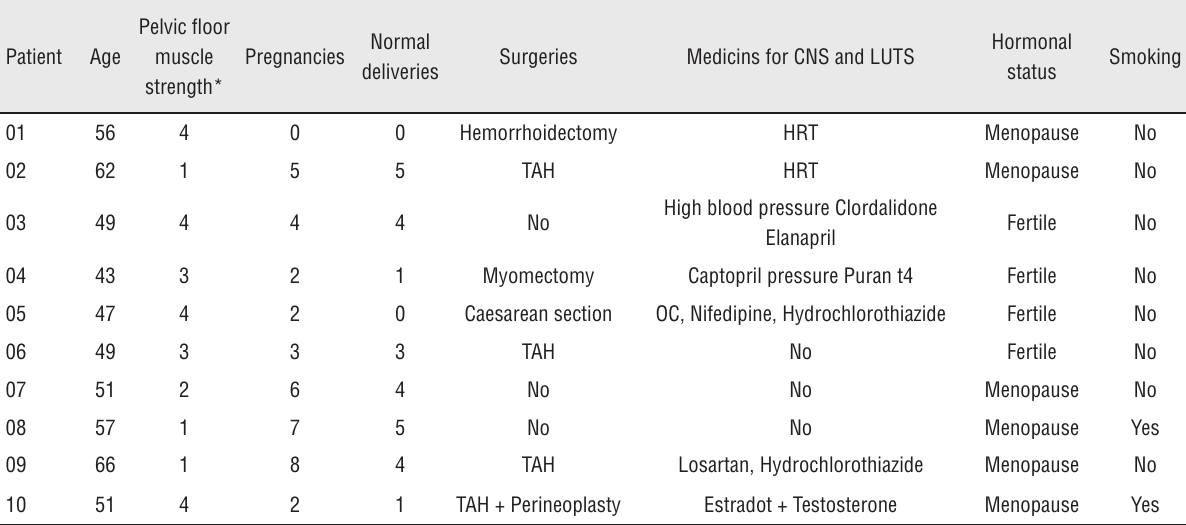
Table 1 - Clinical characteristics of 10 patients who underwent non-ablative radiofrequency treatment on the external urethral meatus, Salvador - BA, 2015.